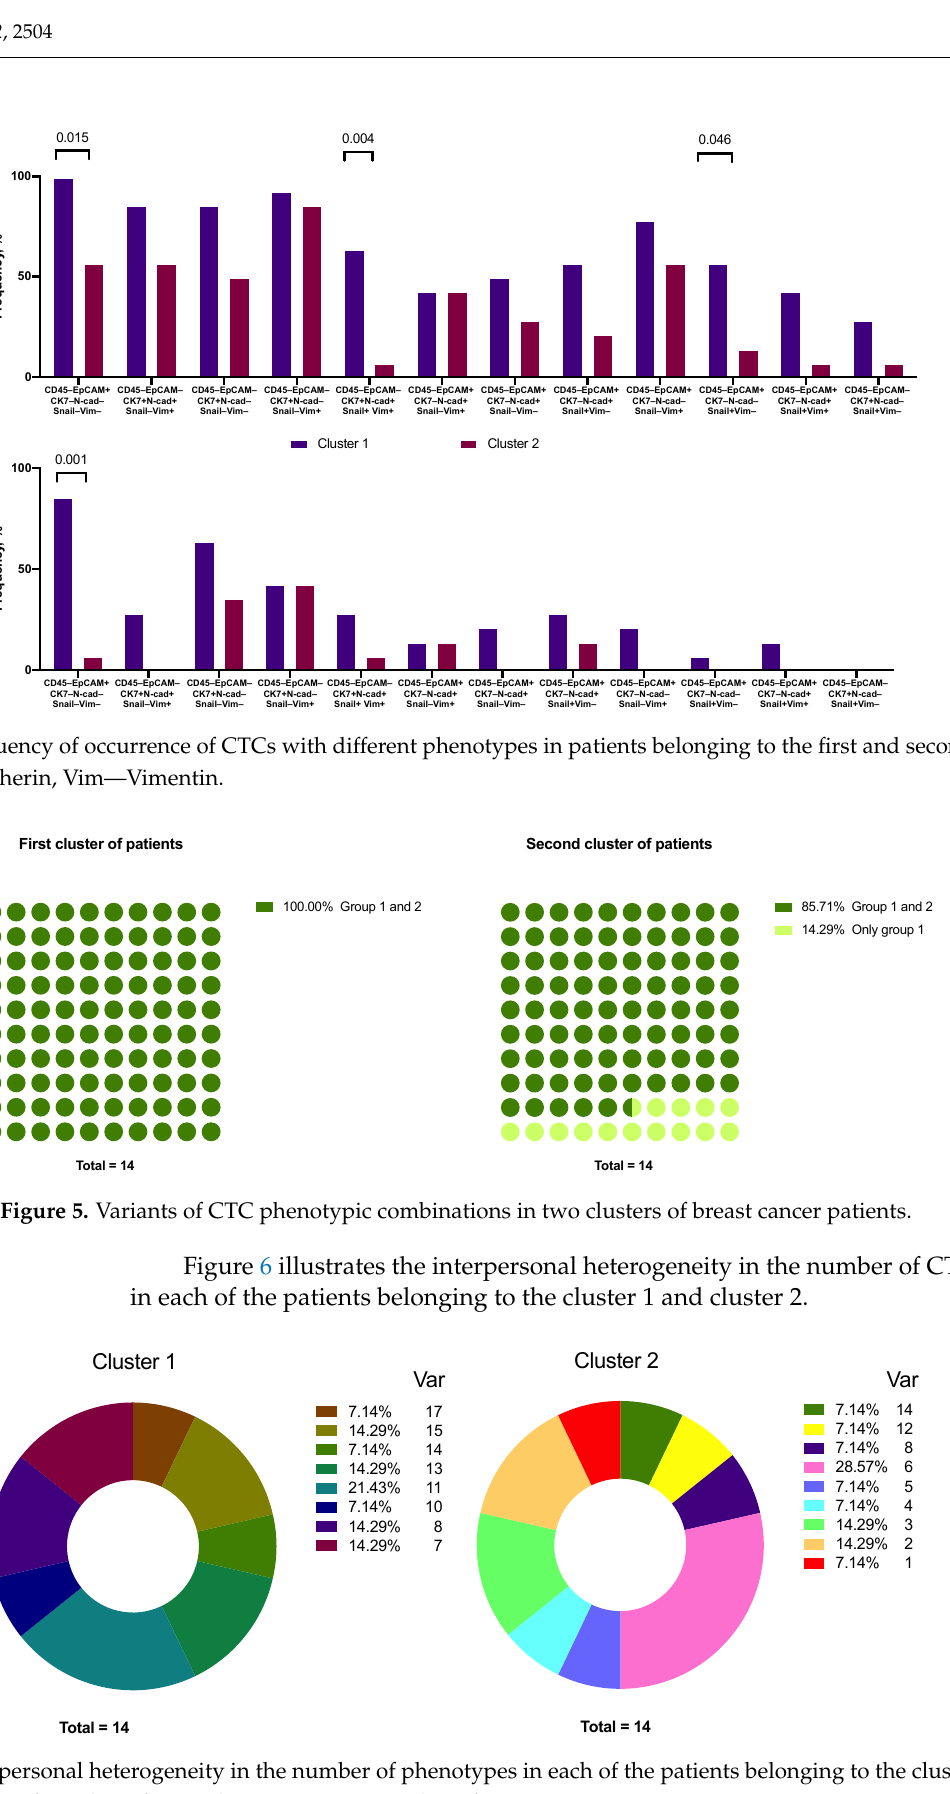
5 of 18 Figure 3. Dendrogram of breast cancer patients by the number of CTCs with different phenotypes. The clusters differed in the total number of CTCs and was 73.45 (48.14–84.86) cells per ml in the first cluster versus 8.88 (6.35–17.97) cells per ml in the second cluster, p = 0.000). The number of CTC phenotypes (in the first cluster 11 (8–14) versus 5.5 (3–6) in the second cluster, p = 0.000). The second cluster differed from the first not only in the smaller number of CTCs phenotypes, but also in the qualitative composition (Figure 4). Among the CTC pheno- types found in patients assigned to the second cluster, CTCs with the following pheno- types: CD45–EpCAM+CK7–Snail–N-cadherin–Vimentin– ( p = 0.015), CD45–EpCAM– CK7+Snail+N-cadherin+Vimentin+